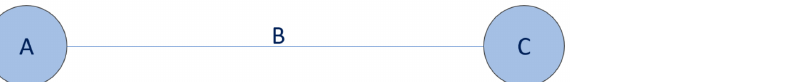
Figure 1. One triplet in KG, where A and C represent two entities while B is the relation between them. Relation B is usually